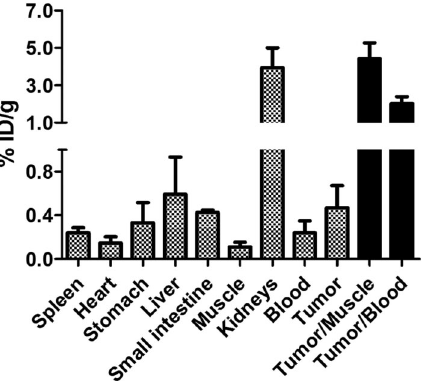
Figure 2. Biodistribution of 99m Tc-HYNIC-Bombesin (7-14) in Capan-1 tumor-bearing mice (% ID/g) after 4 h of intravenous injection